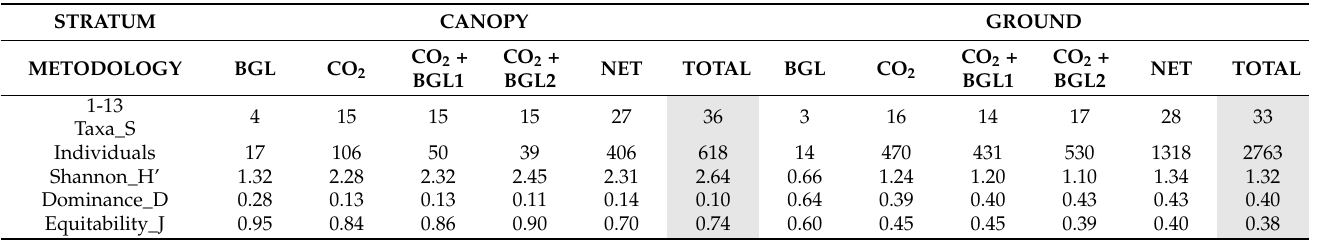
Table 2. Biodiversity indices according to stratum and capture method by total females collected. Guarulhos, SP,